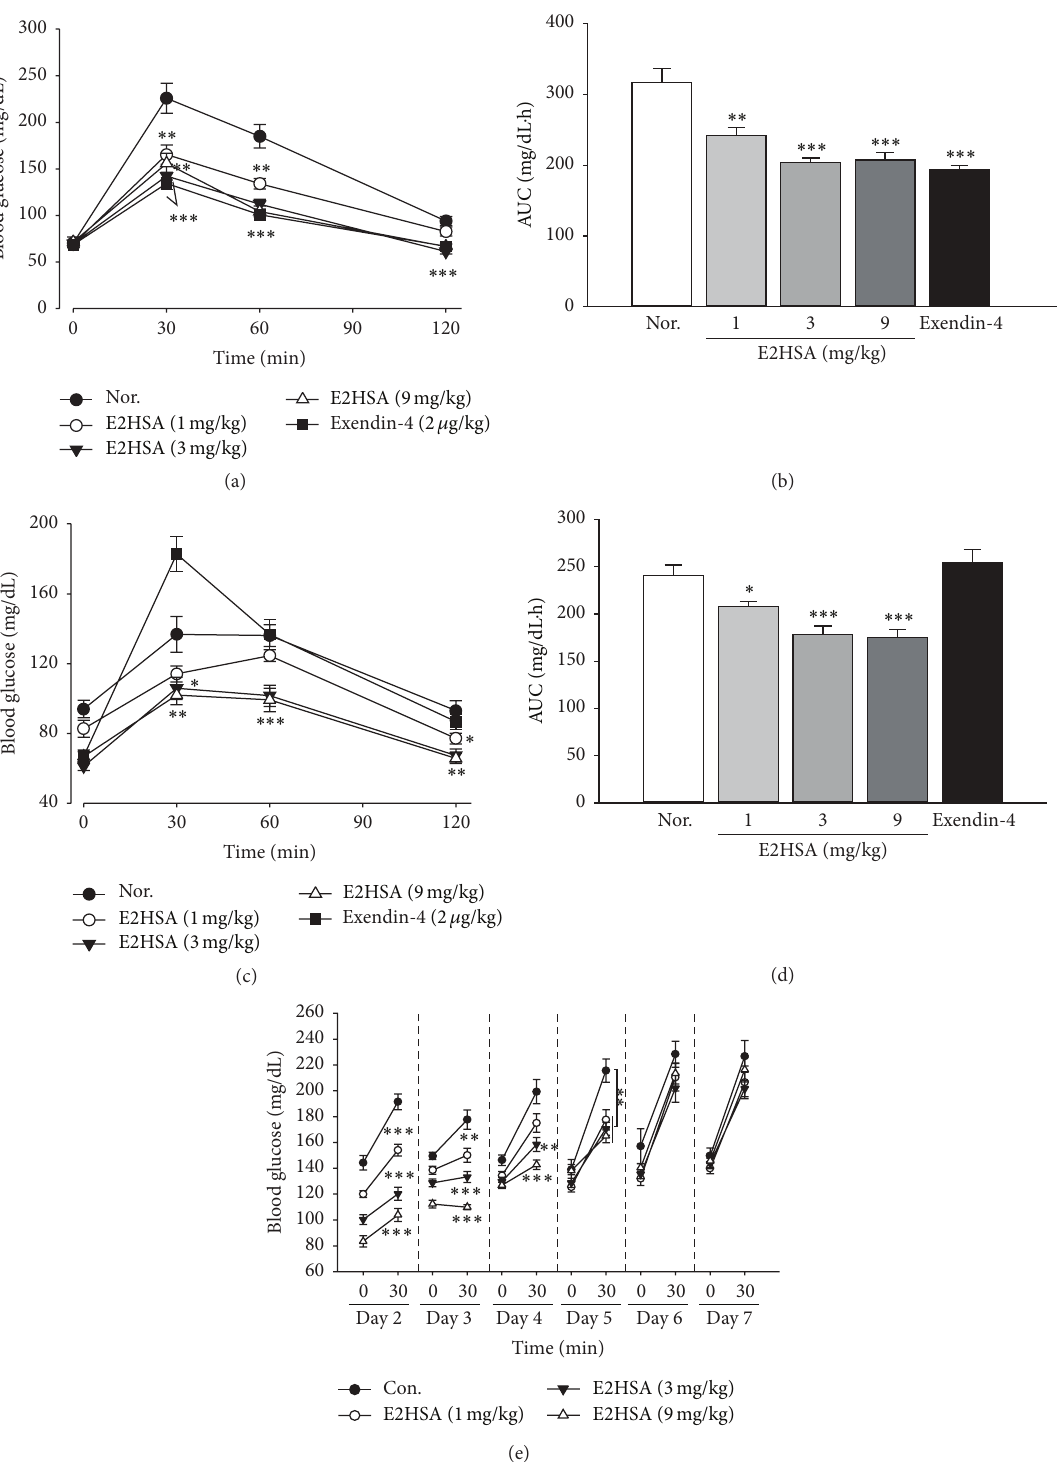
Figure 2: Long-acting, glucose lowering effect of E2HSA following oral glucose challenge in normal ICR mice administered a single dose. ((a)-(b)) Curves of blood glucose and AUC after first oral glucose loading performed at 20 minutes after administration of E2HSA. ((c)-(d)) Curves of blood glucose and AUC after second oral glucose challenge carried out at 4 hours after administration. (e) Blood glucose levels at fasting state and 30 minutes after oral glucose challenge on the 2nd day to 7th day after administration. Nor., normal ICR mice administered normal saline. Exendin-4, exendin-4 treated group. Data are expressed as mean ± S.E.M ( 𝑛 = 10 ). ∗ 𝑃 < 0.05 , ∗∗ 𝑃 < 0.01 , and ∗∗∗ 𝑃 < 0.001 versus